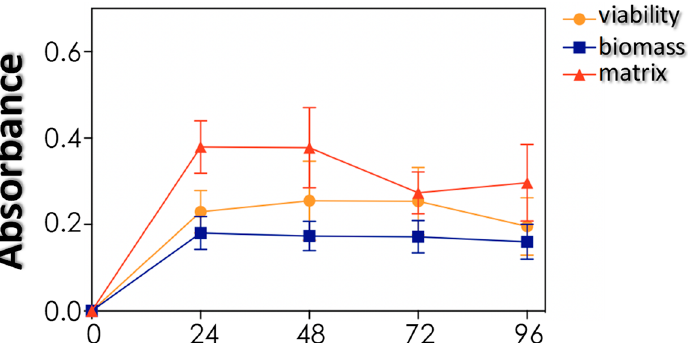
Figure 4. Biofilm formation by S. cerevisiae HUPE-Sc1 strain over a polystyrene surface. Three biofilm parameters were measured: biomass (absorbance at 590 nm), viability (absorbance at 492 nm) and extracellular matrix (absorbance at 530 nm). The results represent means ± standard deviation of three independent experiments.